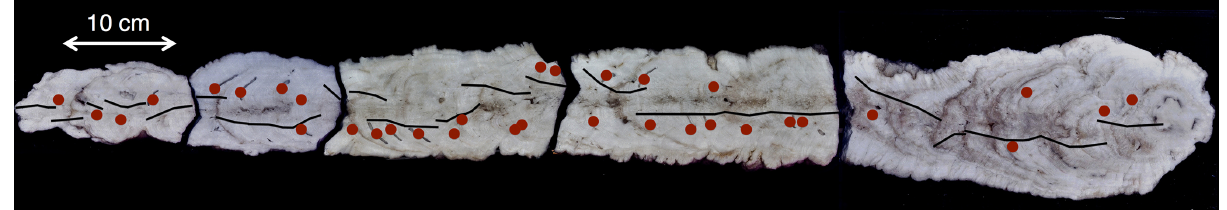
Figure 3. Cross-sectional image of Guadalcanal stalagmite 10FC-02. Stable isotope sample powders were extracted every 500µm along sampling paths shown by black lines. Not all sampling paths are on the same sides of the slabs as depicted. This is to maintain sampling transects on an ideal axis of maximum growth and the center of the growth axis. Red markers on the image indicate sample locations for U–Th